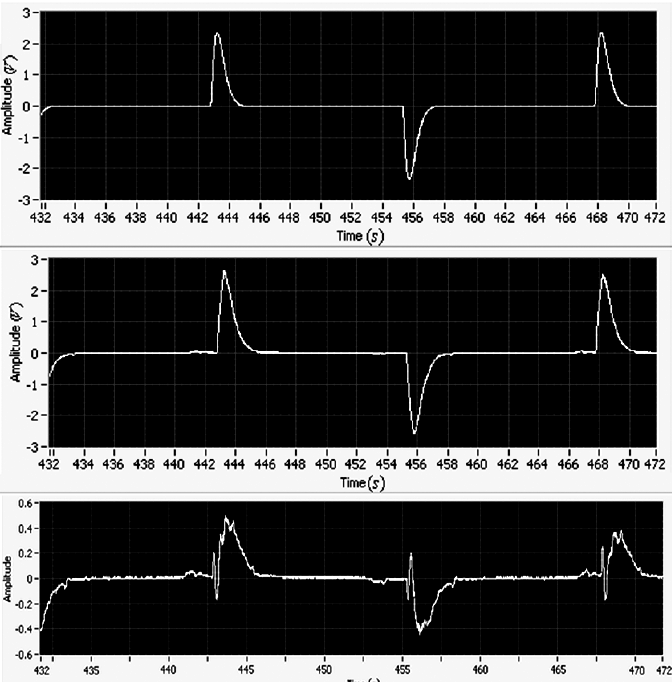
Figure 11. The reference velocity, the motor velocity and the tracking error ( i.e. , ( top ), ( middle ) and ( bottom ), respectively).